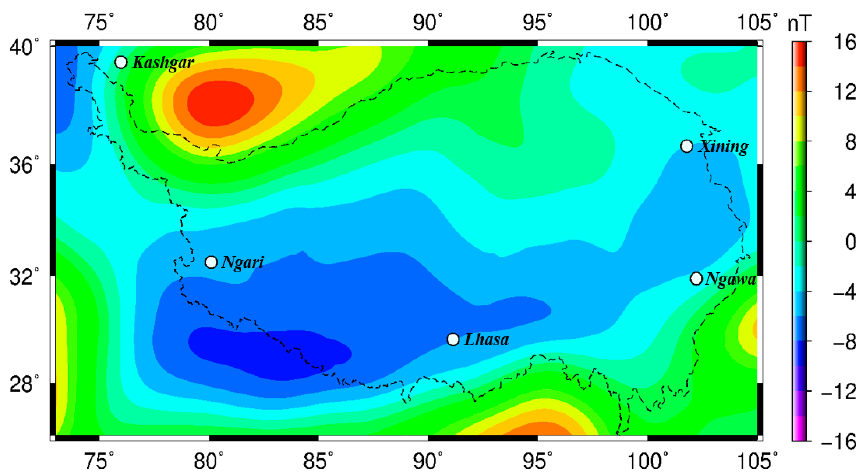
Figure 9. Contour map of Z component of the lithospheric magnetic field at 300 km altitude.